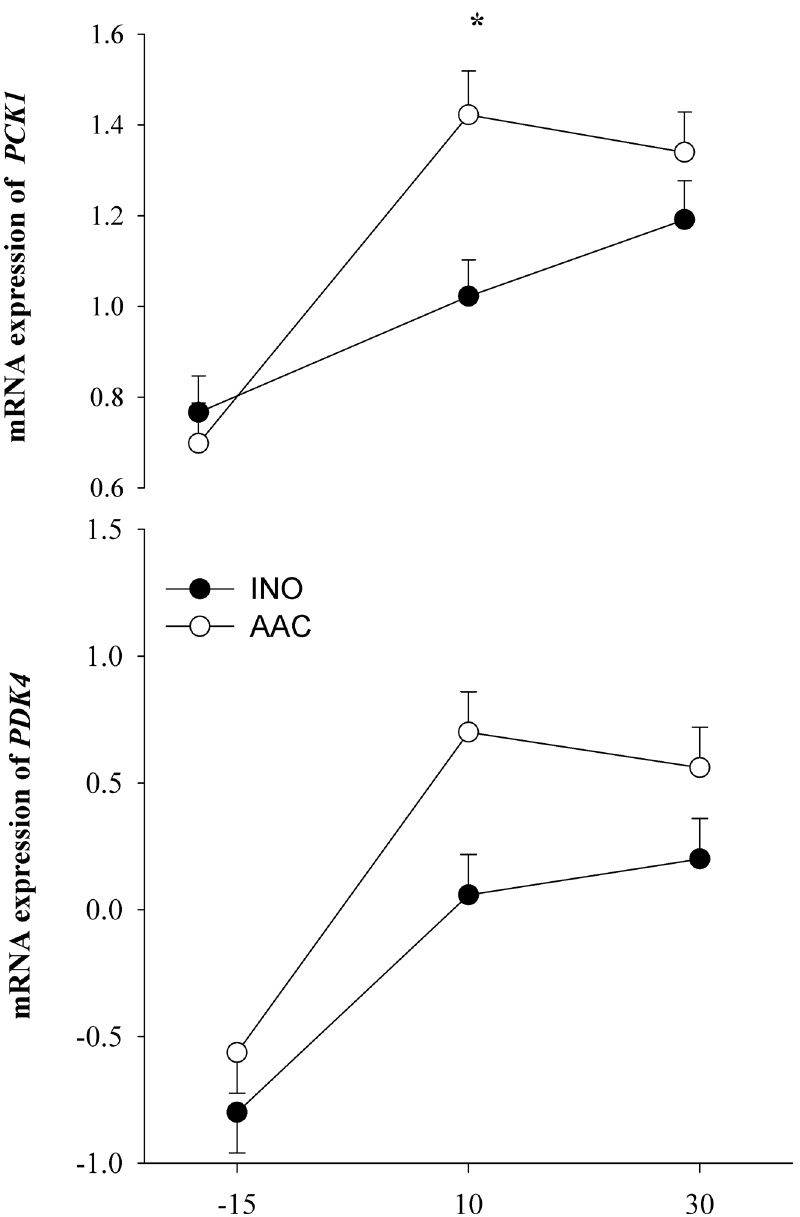
gluconeogenesis. Mean separations between diets at a given time point were evaluated when a D × T effect ( P (cid:2) 0.10) was observed. Differences ( * ) were declared at P (cid:2) 0.05 and trends ( ** ) at P (cid:2)